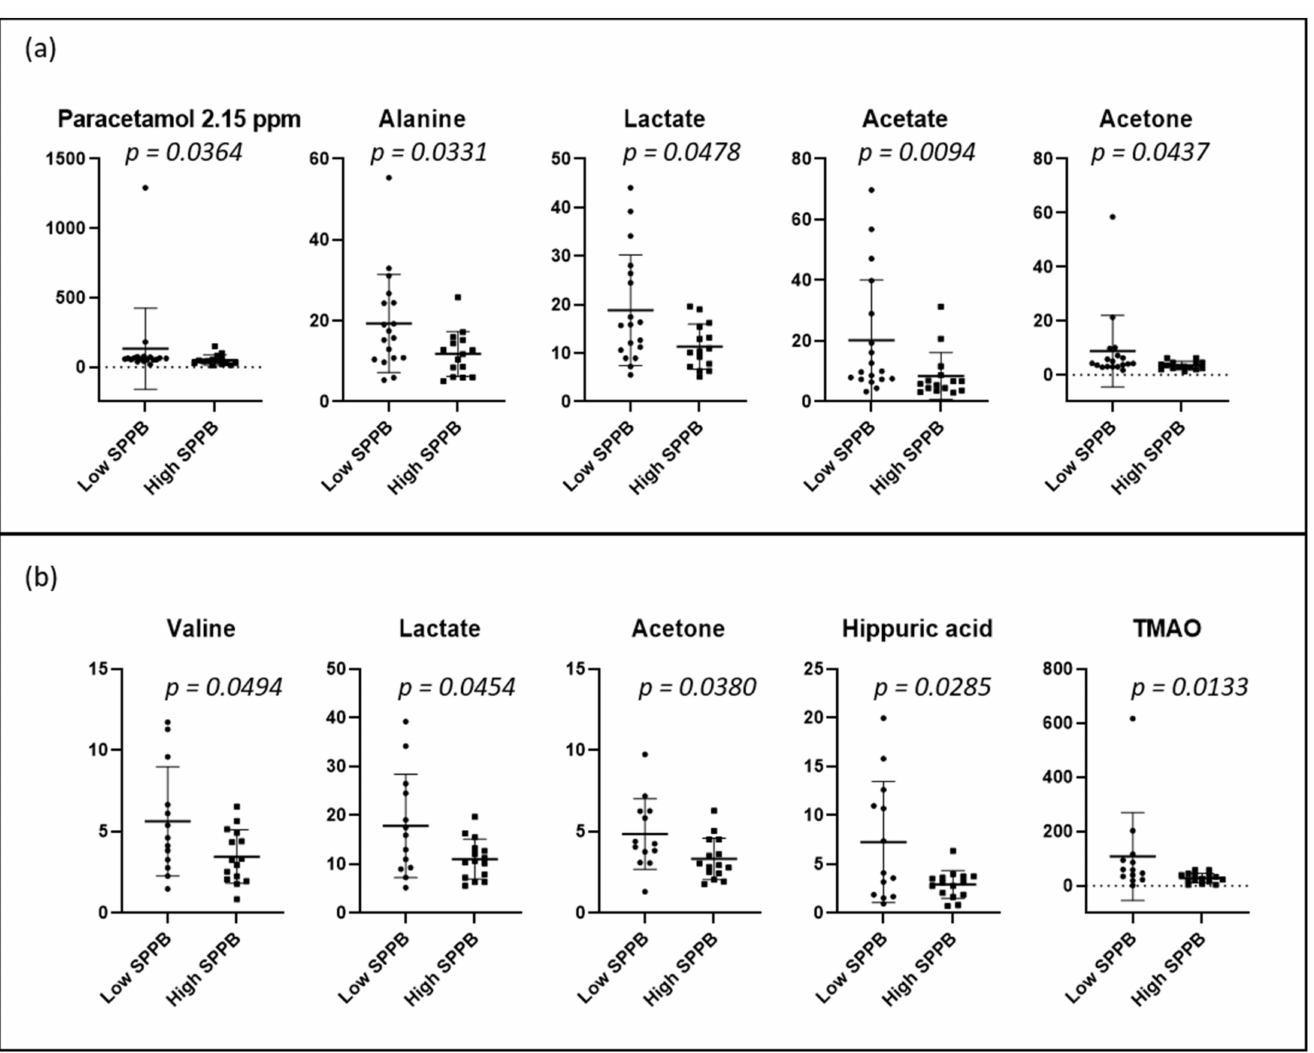
Figure 7. Dot plots of targeted metabolites showing significant differences between groups of high and low SPPB: ( a ) at baseline (low ≤ 3 (n = 18); high >3 (n = 15)), and ( b ) after 12 months (low ≤ 8 (n = 13); high >8 (n = 15)). SPPB groups were dichotomized with medians. Plots represent mean ± standard